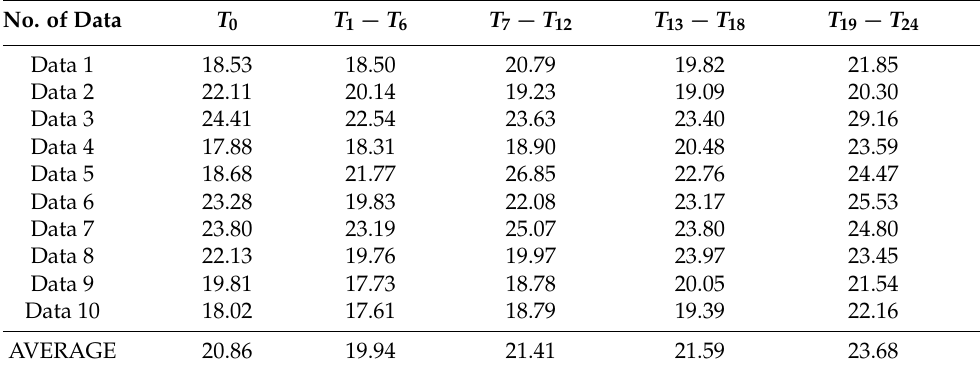
Table 3. The MAE with only MLP as the predictor for all 10 times. The values in the table are the MAE of AQI values.